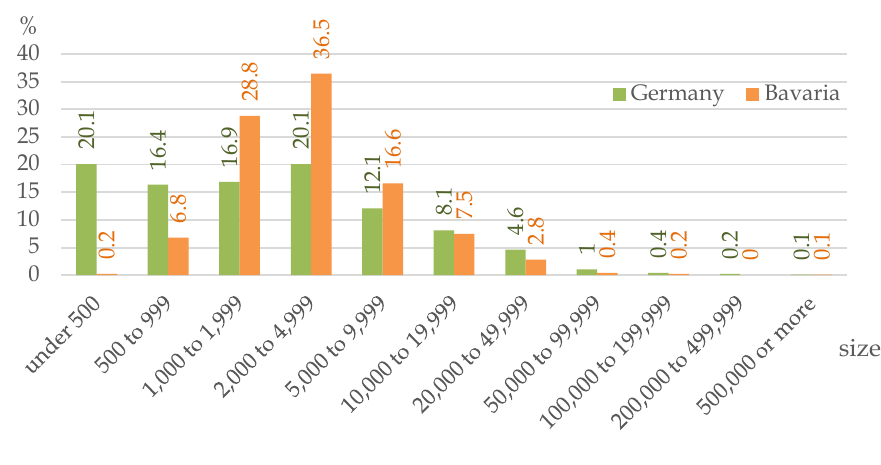
Figure 1: Distribution of communities according to size classes (communities with ... inhabitants), graph based on data of Deutscher Städtetag